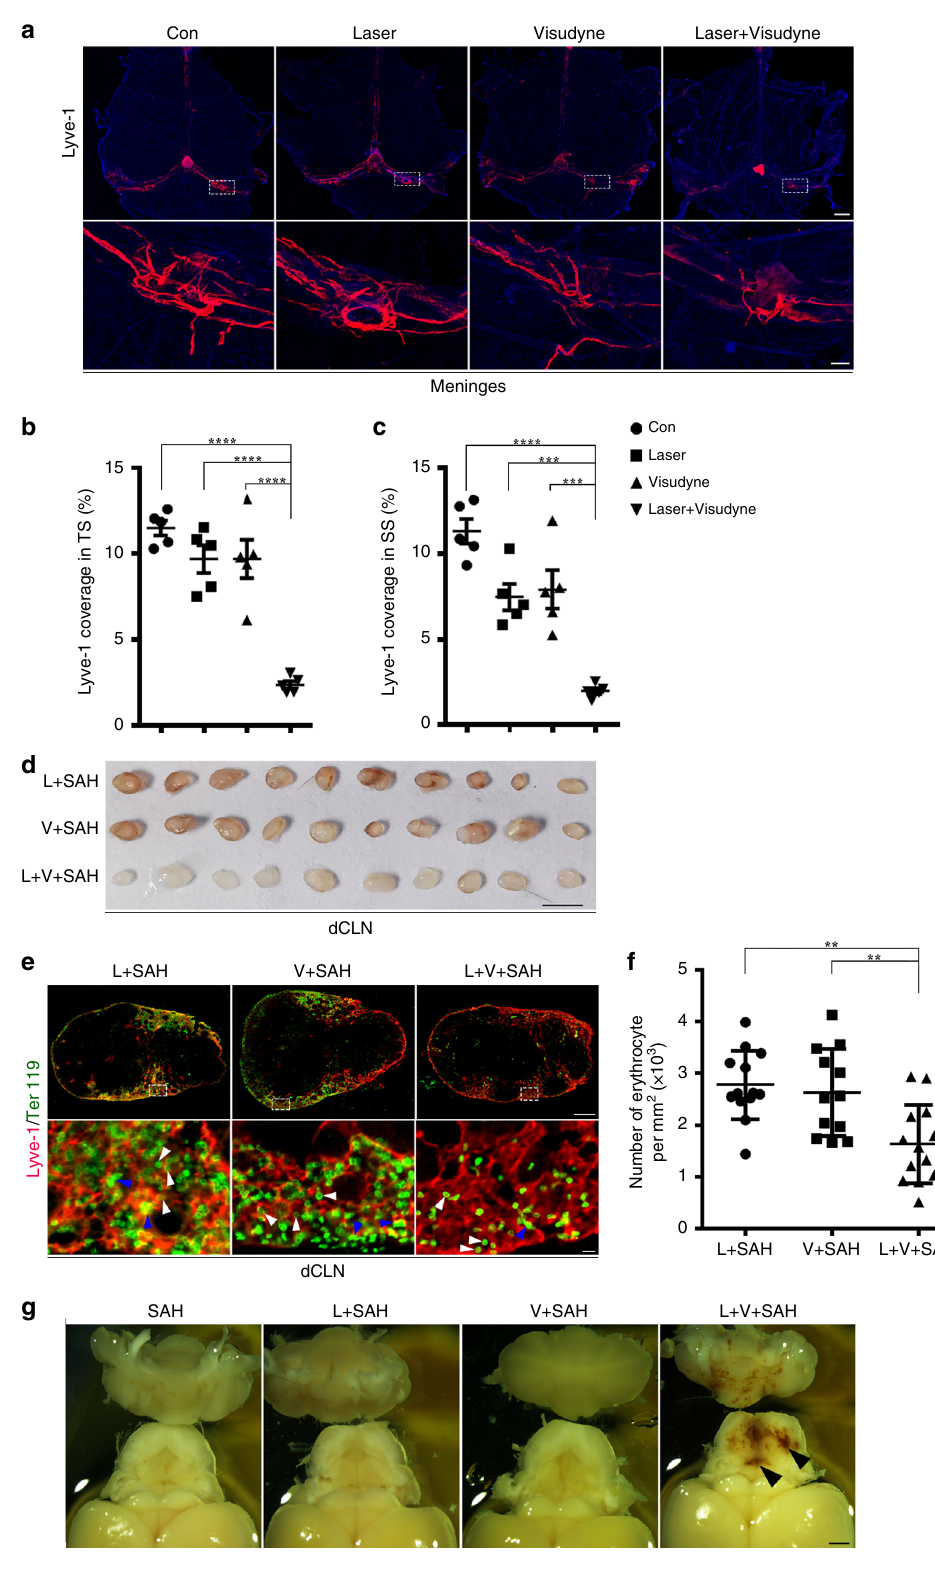
SAH Fig. 4b, d). When compared with the Laser + Visudyne group, the degree of activated microglia polarized to a pro-in fl ammatory phenotype was markedly greater after SAH as evidenced by an increased ratio of CD16/32 + CD206 − subsets and decreased ratio of CD206 + CD16/32 − cells. ( P < 0.0001, L + V vs L + V + SAH